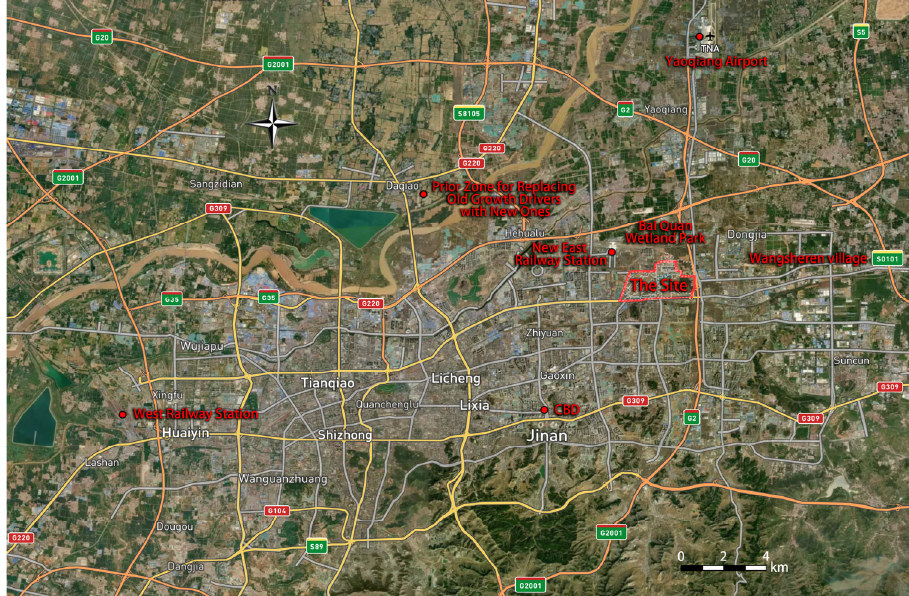
Figure 1. Location of the research case in Jinan.